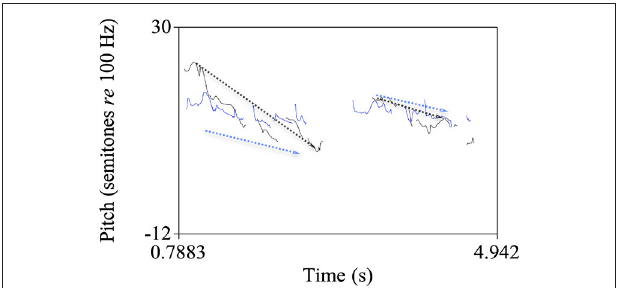
FIGURE 6 | F0 contours of the reading of a verse by two Brazilian female speakers in semitones ref to 100Hz. The black one, with faster falling slopes, was considered less pleasant. The dotted arrows help signal the slopes of the falls for the sake of helping the